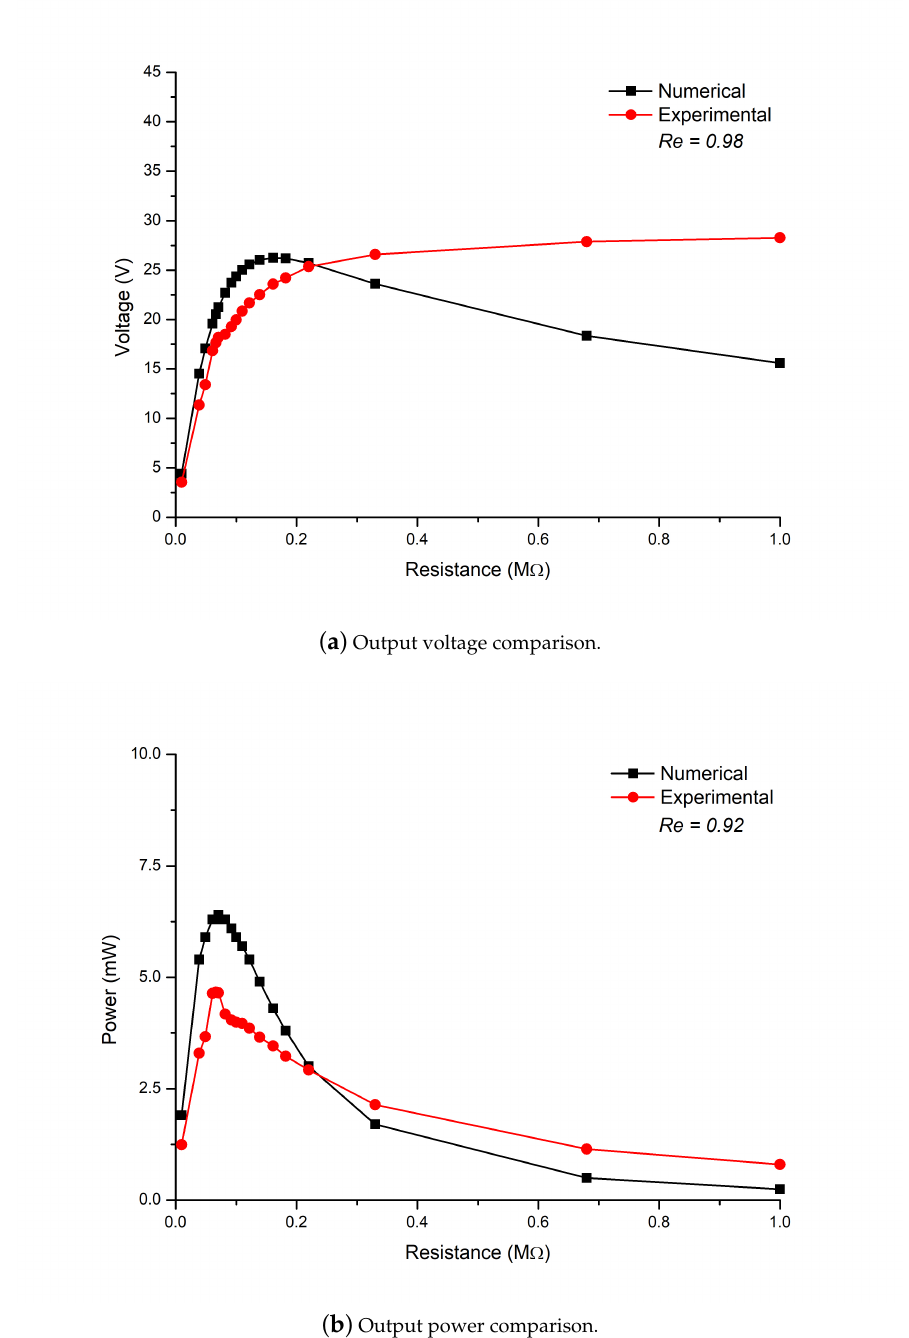
Figure 7. Output voltage and power generated comparison of numerical and experimental data with correlation value; where Re represents the correlation